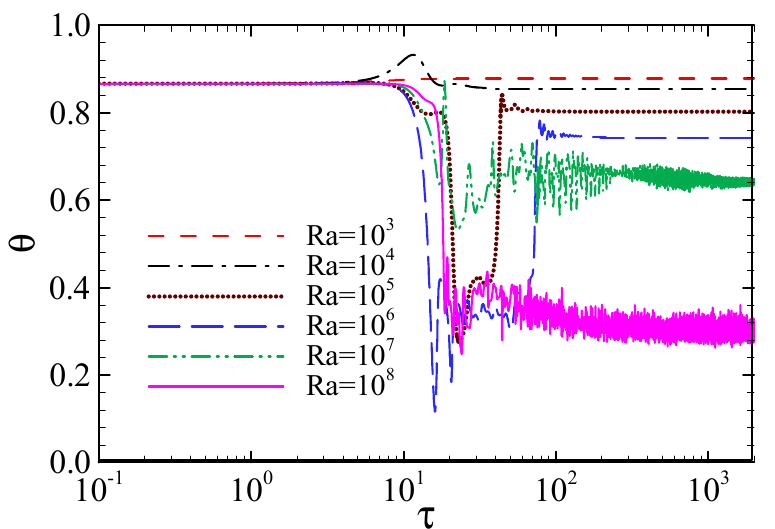
Figure 12. Temperature–time series at point P 1 (0, 0.133) for various Rayleigh numbers.